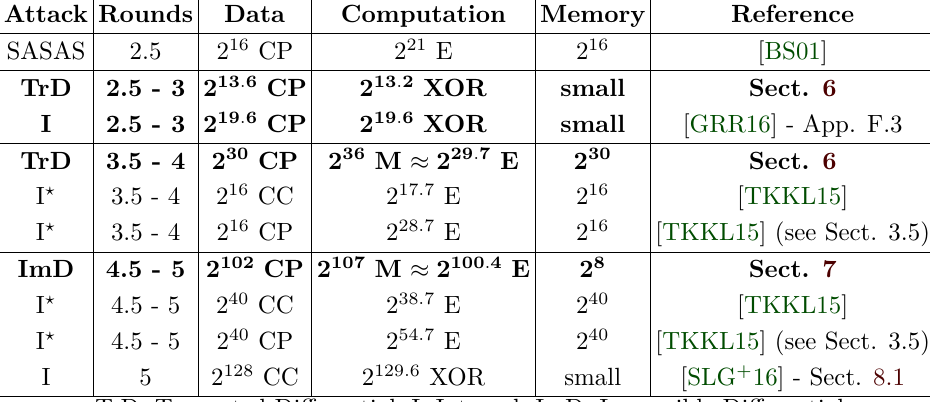
Table 3: Comparison of attacks on round-reduced AES with secret S-Box. Data complexity is measured in number of required chosen plaintexts/ciphertexts (CP/CC). Time complexity is measured in round-reduced AES encryption equivalents (E), in memory accesses (M) or XOR operations (XOR). Memory complexity is measured in plaintexts (16 bytes). The case in which the final MixColumns operation is omitted is denoted by “ r. 5 rounds”, that is r full rounds and the final round. New attacks are in bold. The symbol ? denotes an attack that can not work independently of the S-Box and the key. Attack Rounds Data